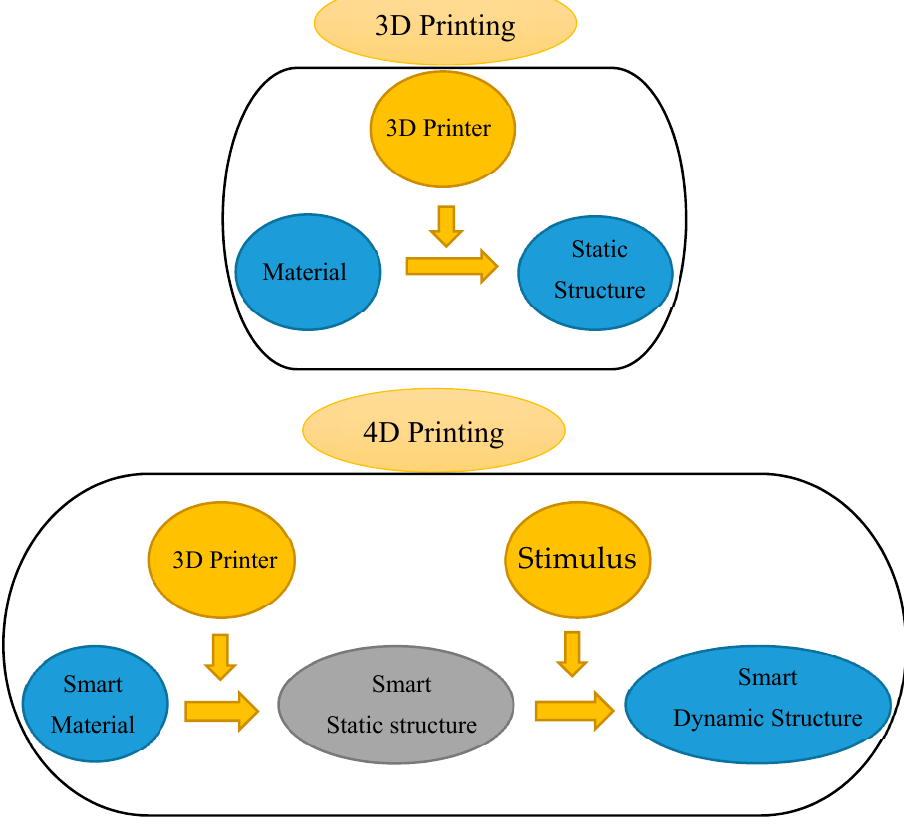
Figure 1. The difference between 3D and 4D printings. Figure 1. The di ff erence between 3D and 4D